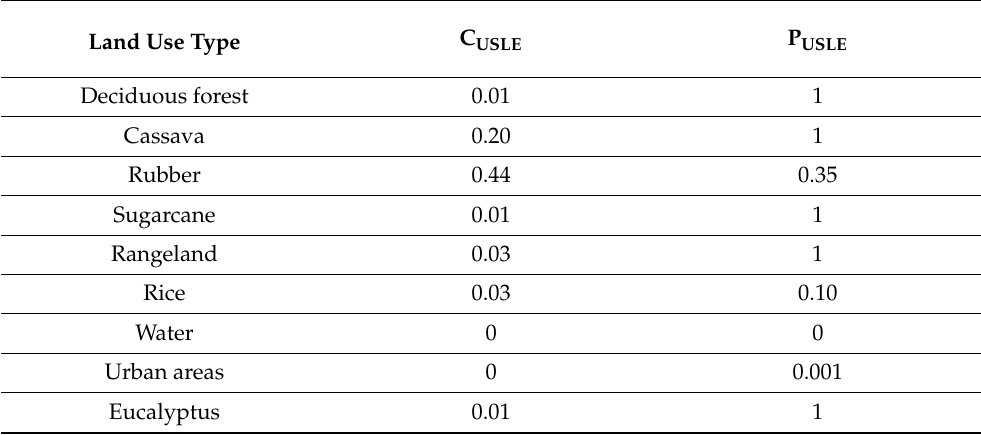
Table 2. Land-use type and corresponding C USLE and P USLE values from the SWAT model database